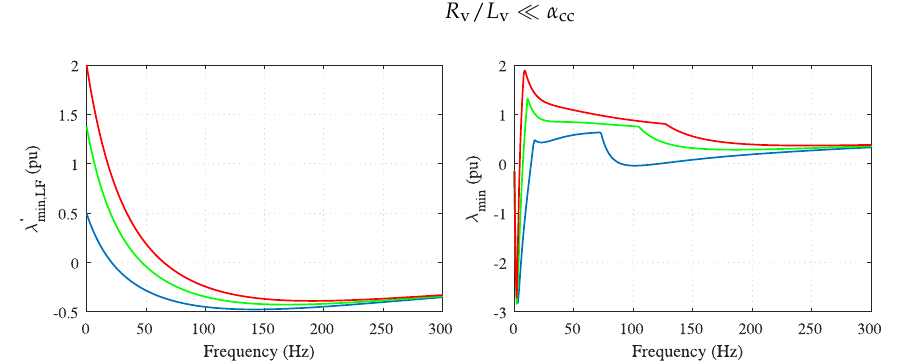
( left ) and λ min ( right ) with L v = 0.2 pu and min,LF